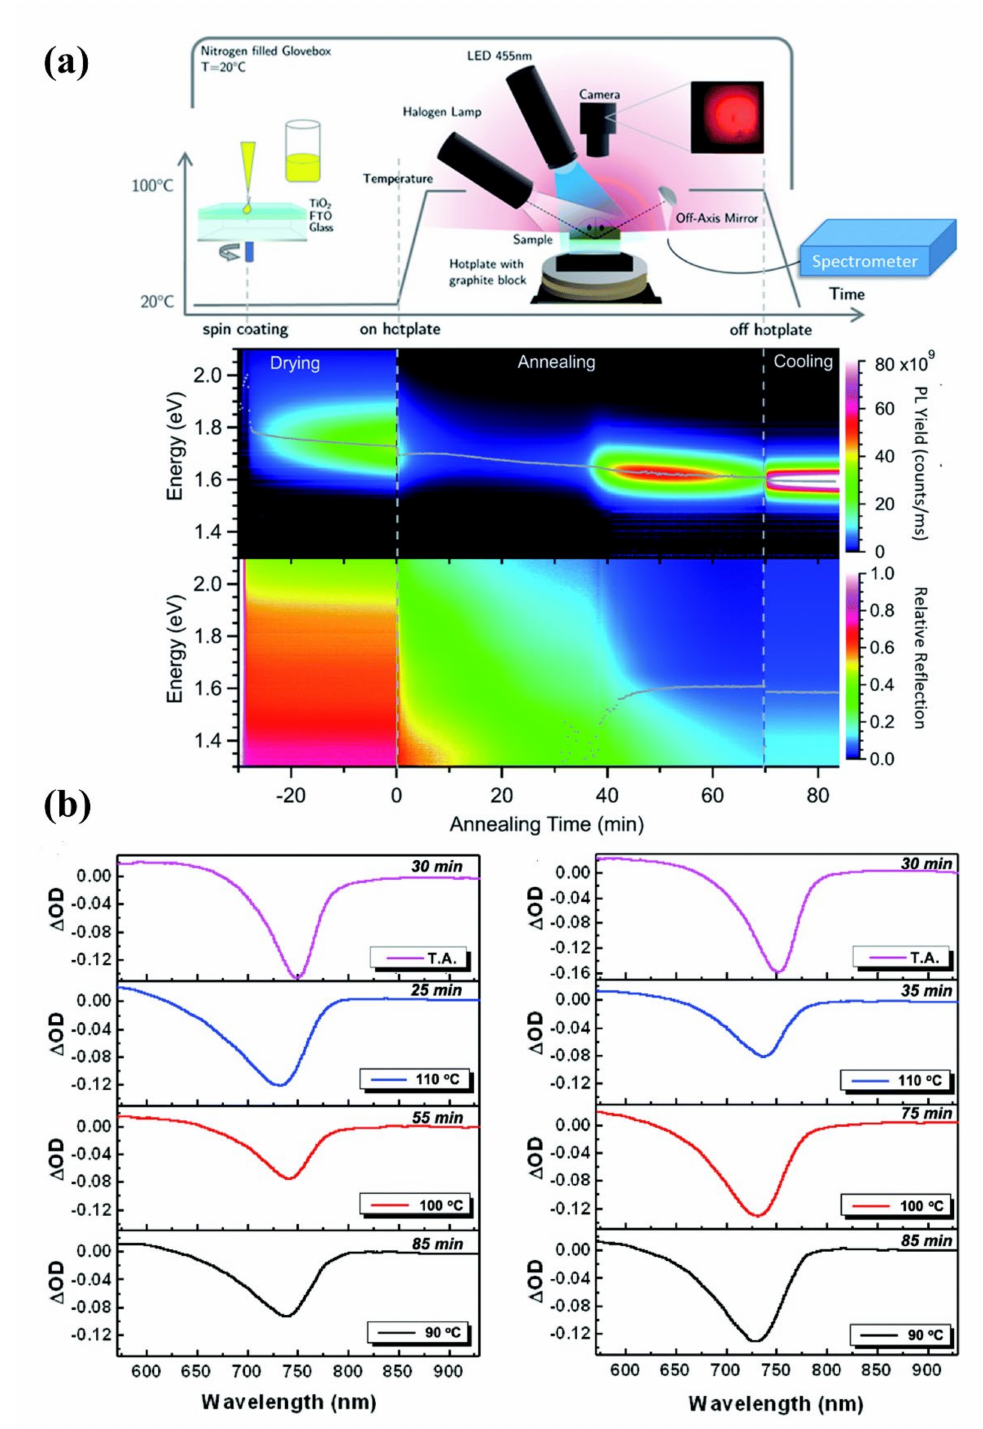
Figure 2. ( a ) Schematic of the glovebox-based synthesis and optical monitoring process, a camera image of the photoluminescence emitted from the sample after 60 min annealing shown in red colors is shown as an inset, a false-color plot of the evolution of photoluminescence (PL), and the reflection spectra during the 3-stage synthesis of chlorine-derived MAPbI 3 − x Cl x . (Reprinted with permission from Ref. [29]. Copyright 2020 Royal Society of Chemistry). ( b ) Typical TAS spectra of ∆ OD as a function of wavelength at t = 0 ps, for 90, 100 and 110 ◦ C, and Glass/ITO/PEDOT: PSS/MAPbI 3 and for Glass/ITO/PTAA/MAPbI 3 . Reprinted with permission from Ref. [30]. Copyright 2019 Royal Society of